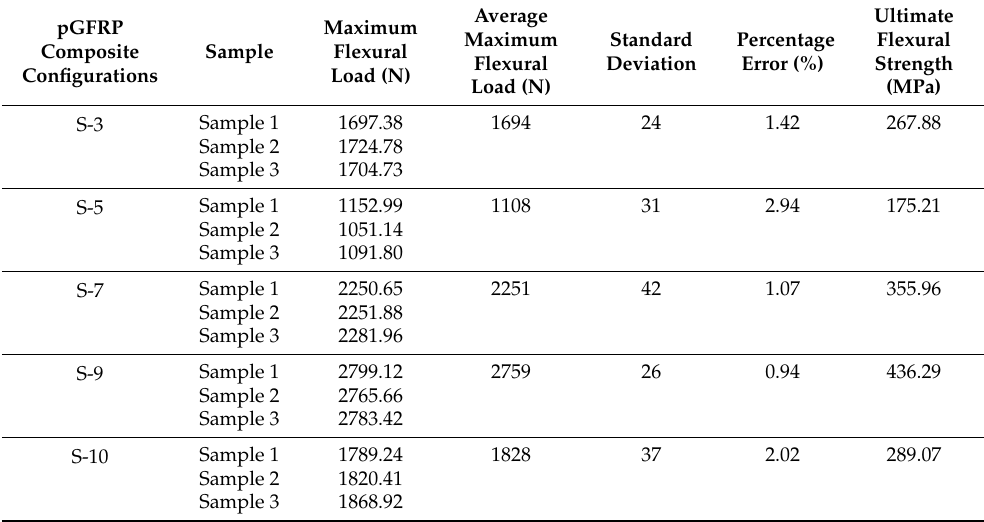
Table 3. Maximum flexural load and ultimate flexural strength of pGFRP